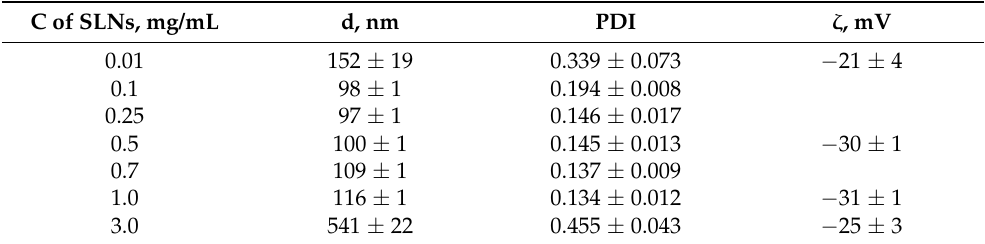
Table 1. CAC values and DLS, and ELS data of SLNs at different concentrations 1 . C of SLNs,